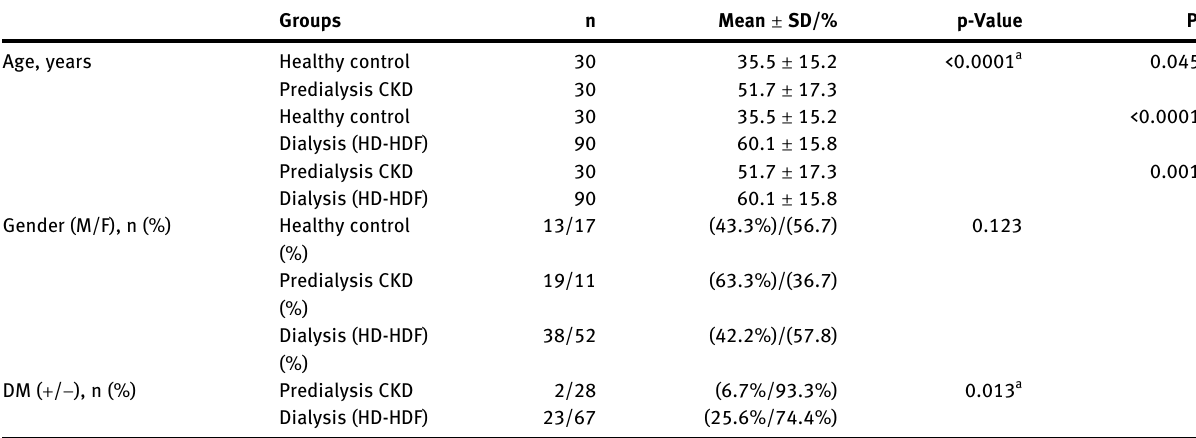
Table  : The demographic characteristics and statistical comparisons of patient groups and healthy controls. Groups